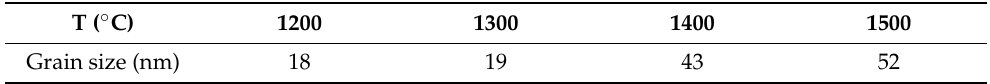
Table 4. Crystallite sizes of sintering powders with different